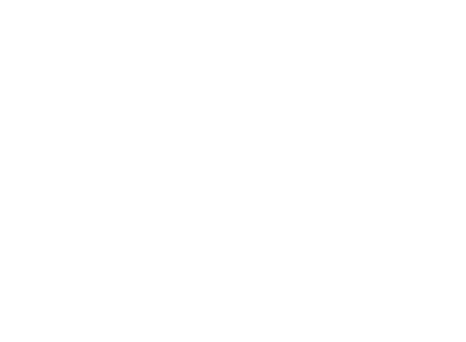
Table 4. Estimated values using combined model from March to December in